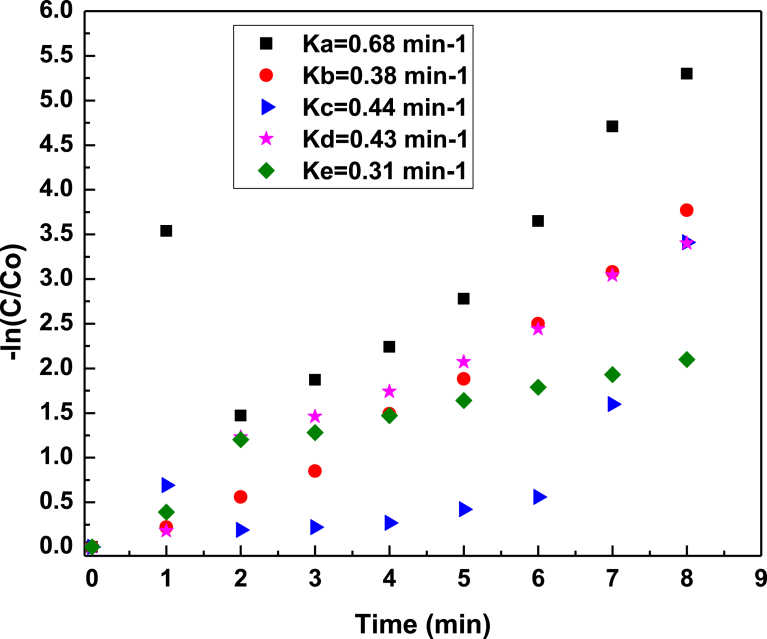
Kinetic curves for dye degradation: (Ka) MB degradation with rejuvenated; (Kb) MO degradation with fresh Ag3PO4; (Kc) RhB degradation with fresh Ag3PO4; (Kd) MB degradation with fresh Ag3PO4; (Ke) MB degradation with 4th recycled Ag3PO4.